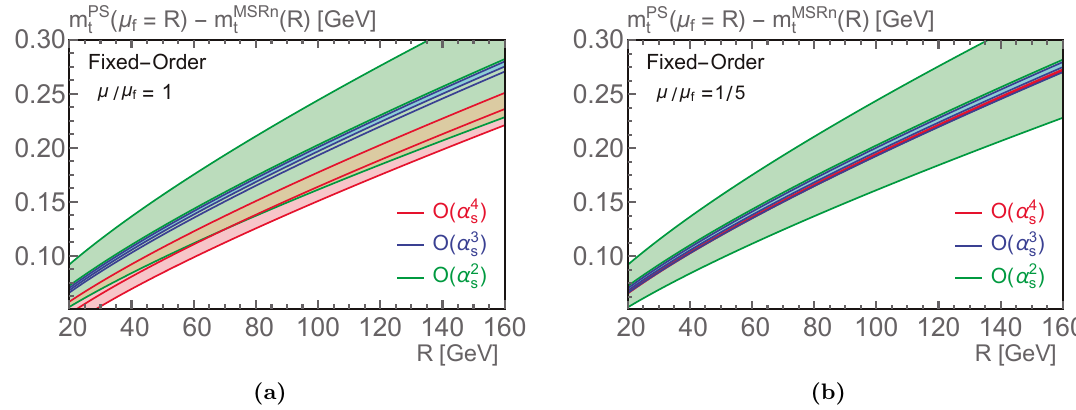
Figure 4. Di(cid:11)erence between the natural MSR and PS ( (cid:22) f = R ) top quark mass ( n ‘ = 5) as a function of R in GeV at two, three and four loops (the one loop result vanishes). Results are shown for two di(cid:11)erent choices of the IR subtraction scale, (cid:22)=(cid:22) f = 1 and (cid:22)=(cid:22) f = 1 = 5.